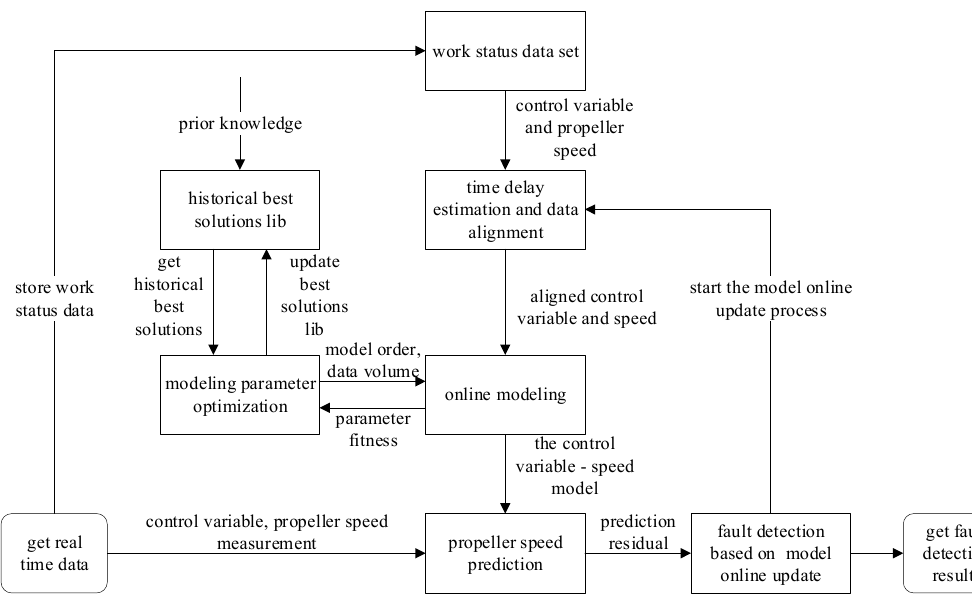
Figure 1. Structure of the online learning-based fault detection algorithm.